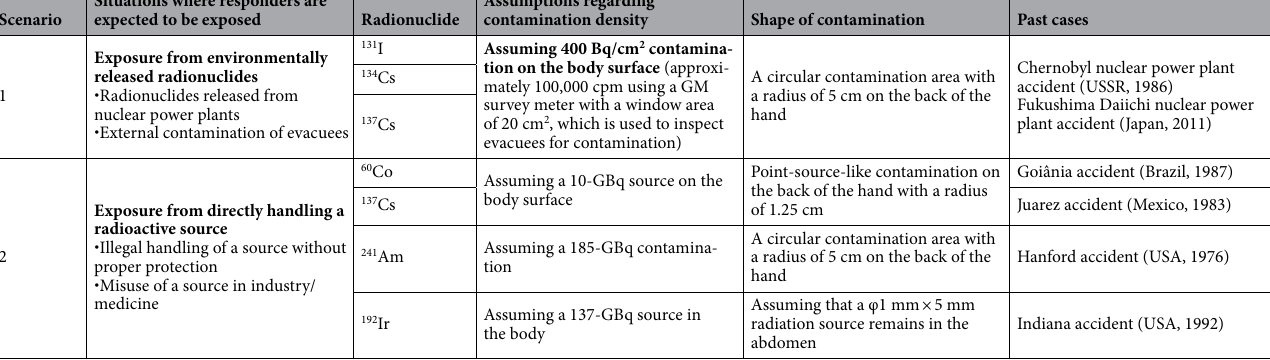
Table 1. Assumptions regarding radionucleotides that are attached to a contaminated patient in this